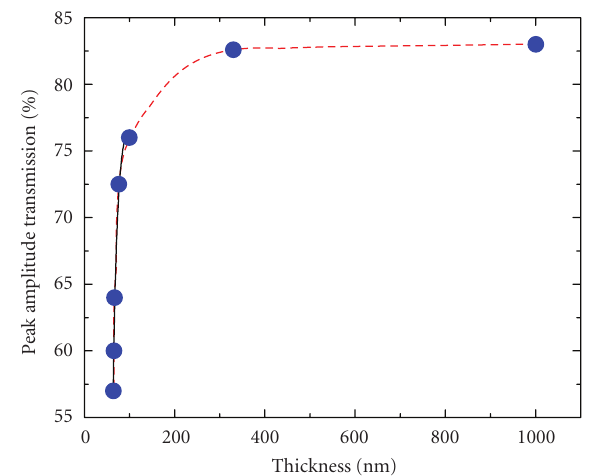
Figure 4: Peak amplitude transmission of the SP [ ± 1,0] mode at 0.55 THz as a function of the Pb thickness (circles). The solid curve is an exponential fit to the data with array thickness below 100 nm. The dashed curve is a guide to the